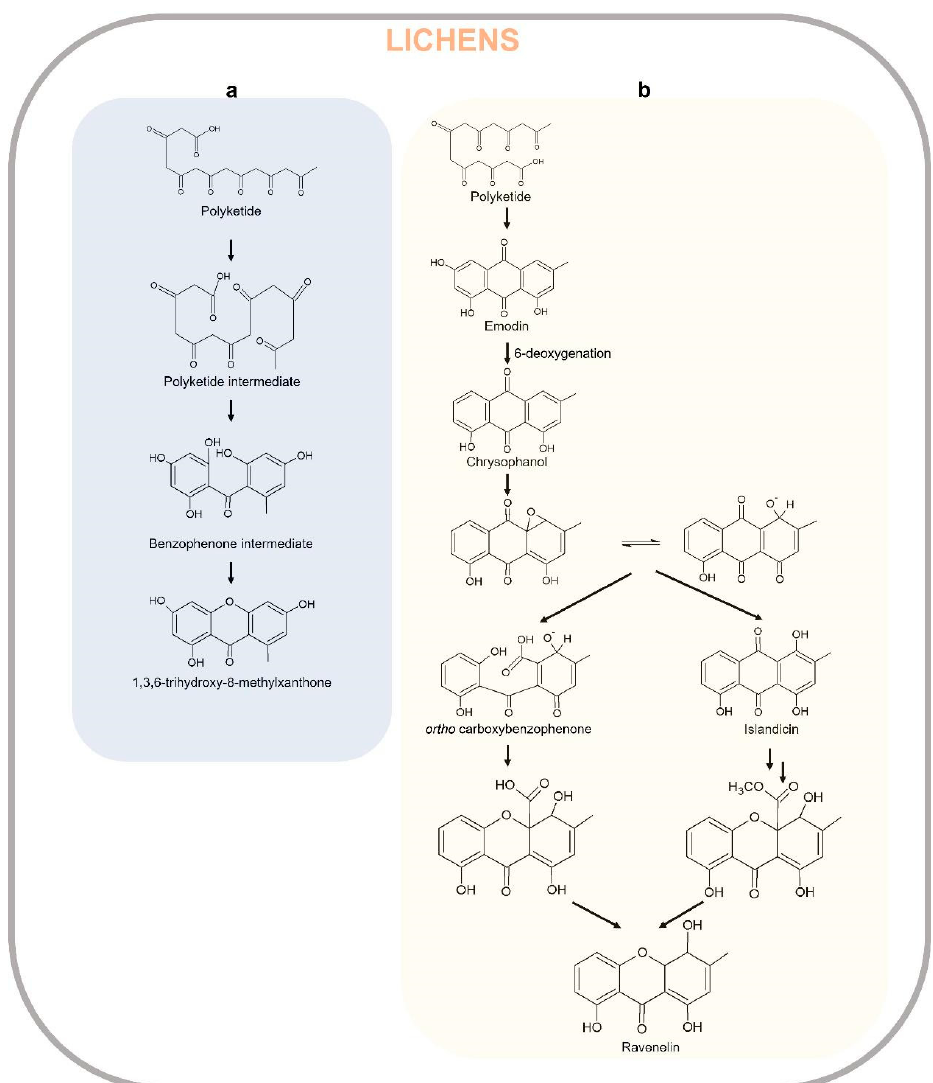
Figure 10. Xanthone biosynthetic pathways in lichens. Lichexanthone-type lichen xanthone ( a ) and thiomielin-type lichen xanthone pathway ( b ).